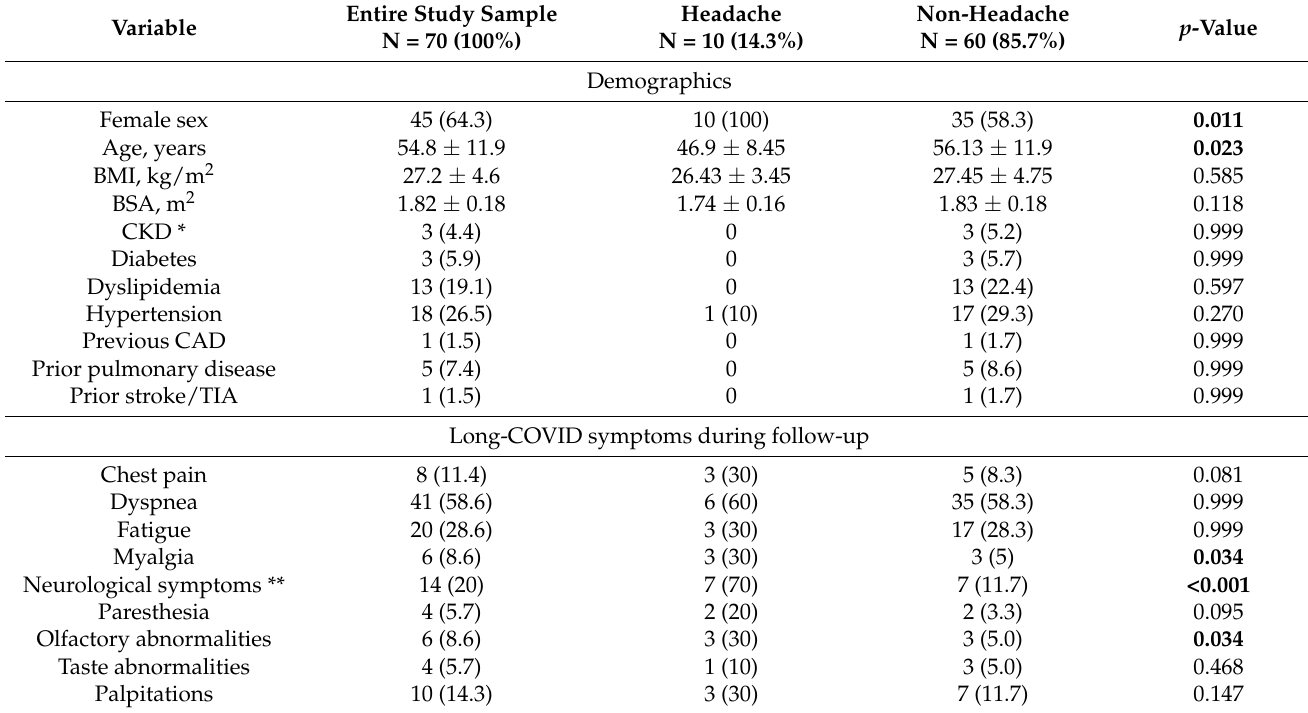
Table 1. Baseline characteristics of patients according to the presence or absence of long-COVID headache during